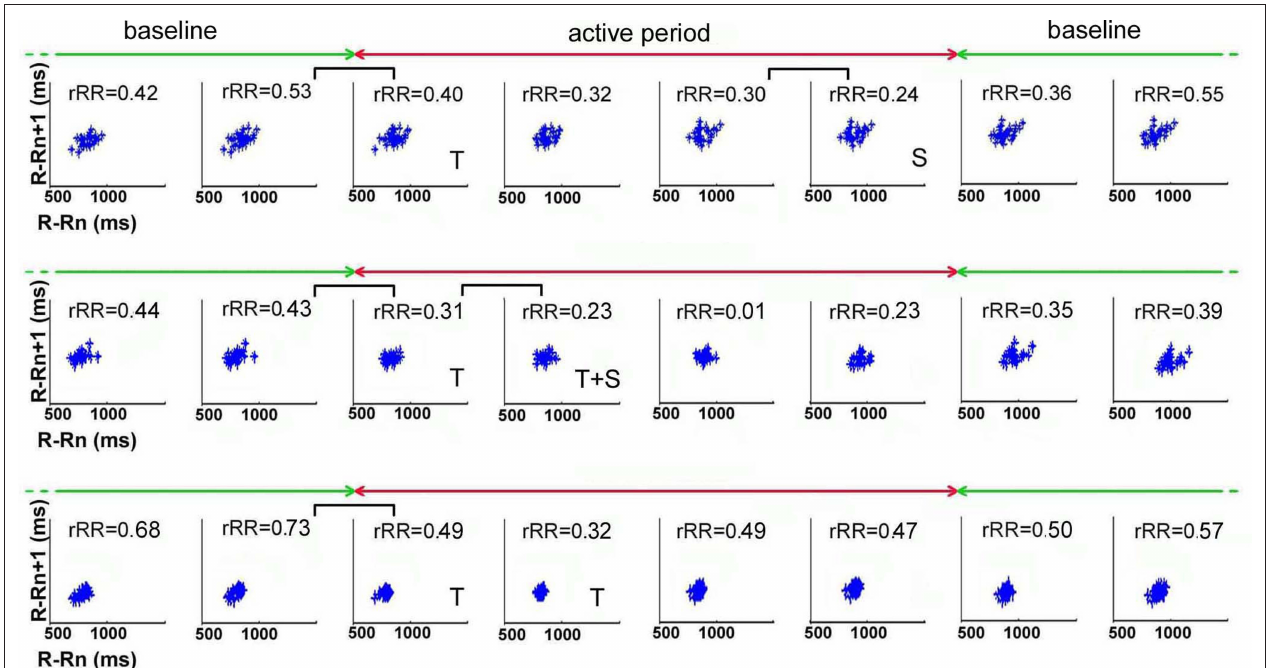
the subject’s timesheet reports. The successive plots present distinctive patterns as a function of the rRR value. The points spread out further along the diagonal in plots outside the active period, while they cluster together within the active period. The R-R autocorrelation coefficient (rRR), i.e., the correlation coefficient between R-R( n ) and R-R( n + 1), was worked out in each window. The decrease in rRR denotes predominant vagal influence (Otzenberger et al., 1998). The brackets refer to statistical inferences, computed on rRR prior to and at the onset of events of interest [i.e., initial theatrical events and all subjective events